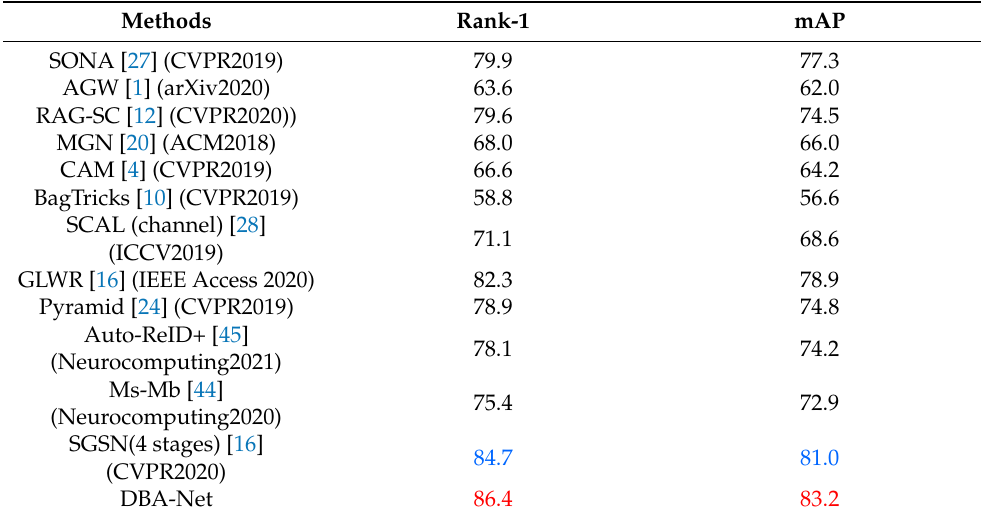
Table 5. Comparison with the SOTA methods on the CUHK-03(detected). The best performance is shown in red, and the second best performance is shown in